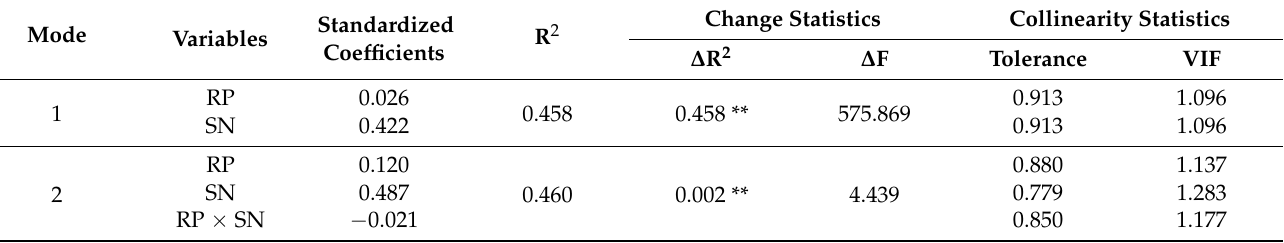
Table 2. Moderated regression analyses of